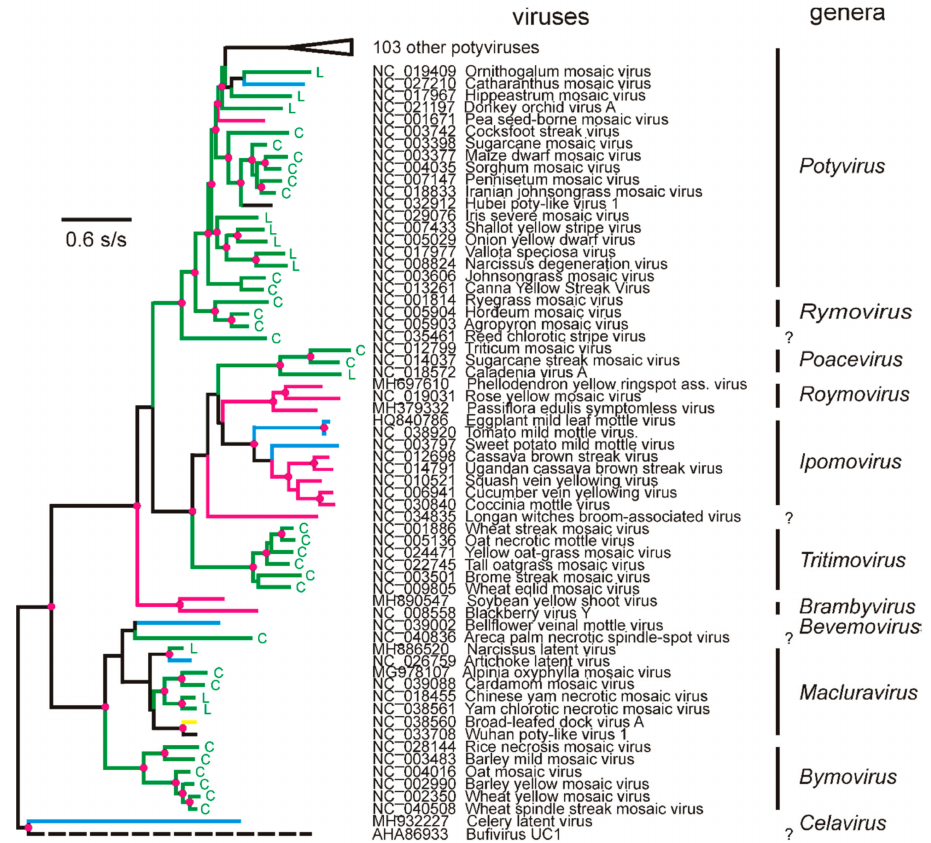
Figure 2. A maximum likelihood (ML) phylogeny of 166 potyvirids, calculated using the same methods as [29–31], from the protein sequences encoded by the RdRp regions of all genomes with GenBank Reference Sequence Accession Codes (July 2019), together with any others that had unique names. The most closely related non-potyvirid, bufivirus UC1, is included as an outlier. Branch colors indicate the major angiosperm “Order” from which each virus was isolated (i.e., its “primary host”); eudicotyledon rosid (red), asterid (blue), or caryophyllid (yellow) and monocotyledon (green) alismatid “A”, lilioid “L”, or commelinid “C”. The RdRps of potyviruses branching most closely to the rymoviruses are shown, and the phylogeny of the other 103 is collapsed. The nodes with a red disk have > 0.9 SH